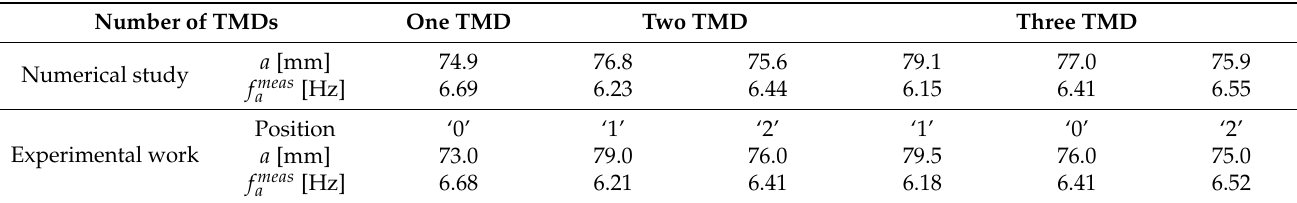
Table 2. Frequencies of one, two, and three TMDs system for the optimal positions obtained from a numerical study carried out by Gebai [22] and their corresponding nearest frequencies used for the current experimental work.